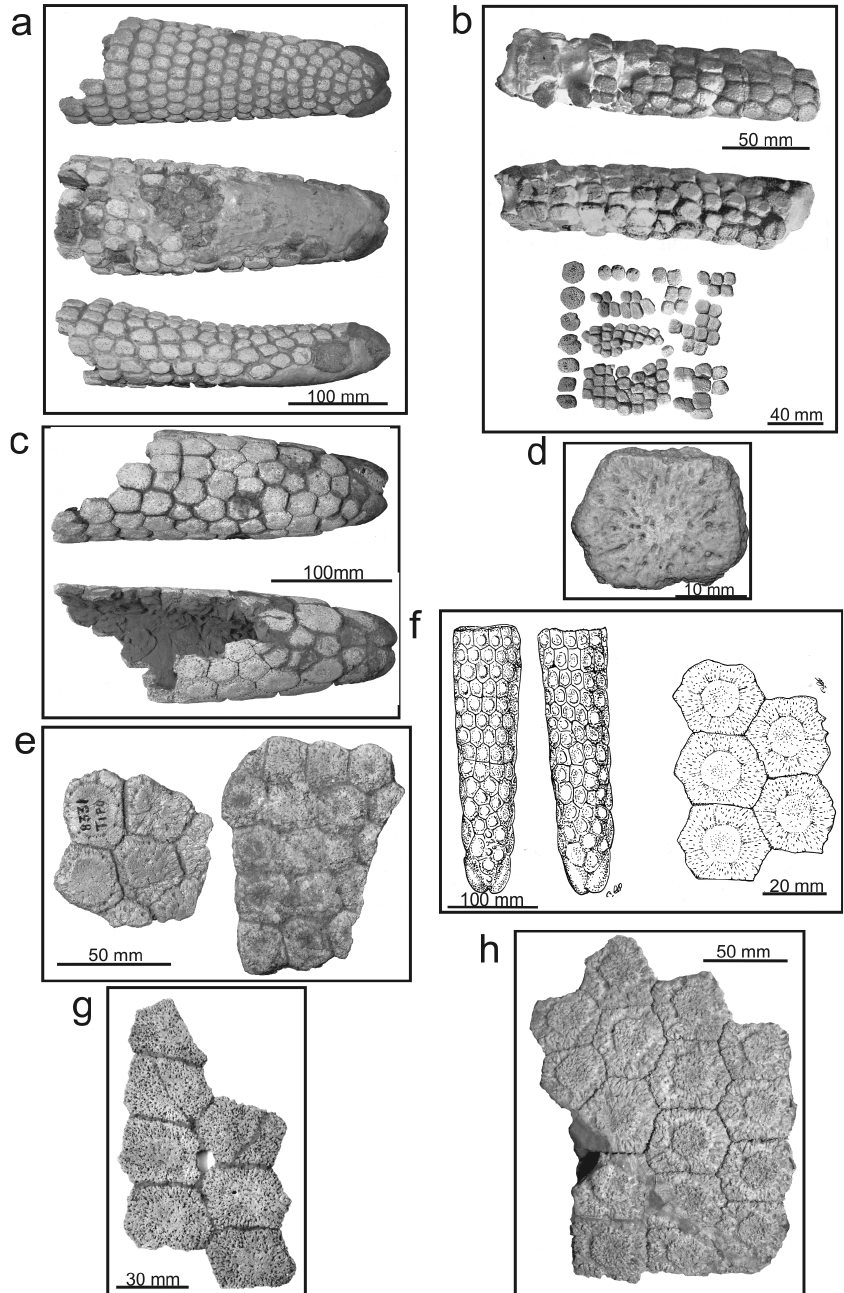
Figure 3 - a, Urotherium simplex (MACN Pv 5813 holotype), restored caudal tube in dorsal, ventral and lateral views; b, Urotherium simile , restored caudal tube in ventral and dorsal views (MFCA 727 holotype), associated osteoderms of the dorsal carapace (MFCA 593); c, Lomaphorus chapadmalensis (MACN Pv 5806 holotype), distal portion of caudal tube in ventral and dorsal views; d , Lomaphorus cingulatus (MACN A-592 calcotype), osteoderm of the dorsal carapace; e, Lomaphorops corallinus (MACN Pv 8331 holotype) associated osteoderms of the antero-lateral region of the dorsal carapace; f, Lomaphorus imperfectus (modi fi ed from Ameghino, 1889, plate 58, fi gs. 1 and 3), caudal tube in dorsal and ventral views and associated osteoderms of the dorsal carapace; g, Trachycalyptus chapadmalensis (MACN Pv 5823 holotype), 7 associated osteoderms of the lateral region of the dorsal carapace; h, Paraglyptodon chapadmalensis (MACN Pv 6162 holotype), 16 assocciated osteoderms of the lateral region of the dorsal